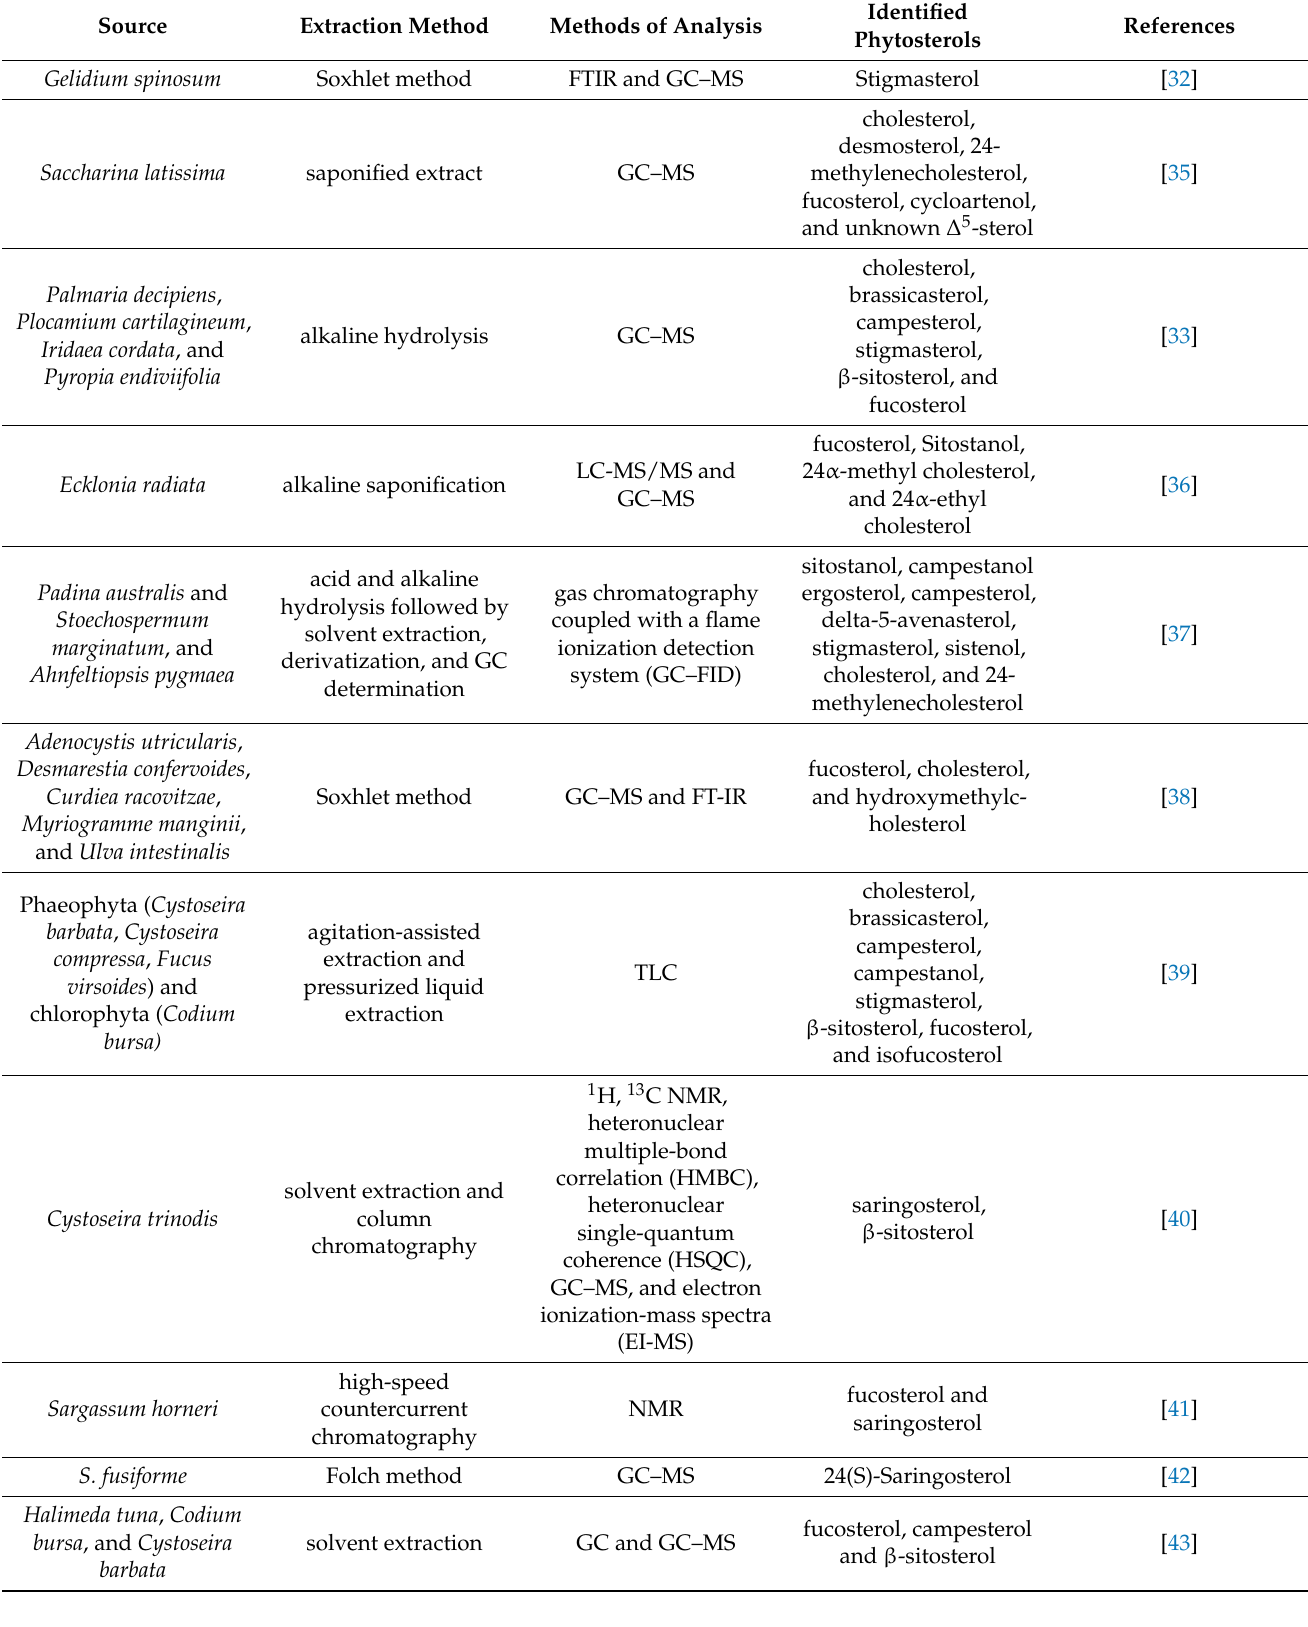
Table 1. Examples of phytosterols identified from